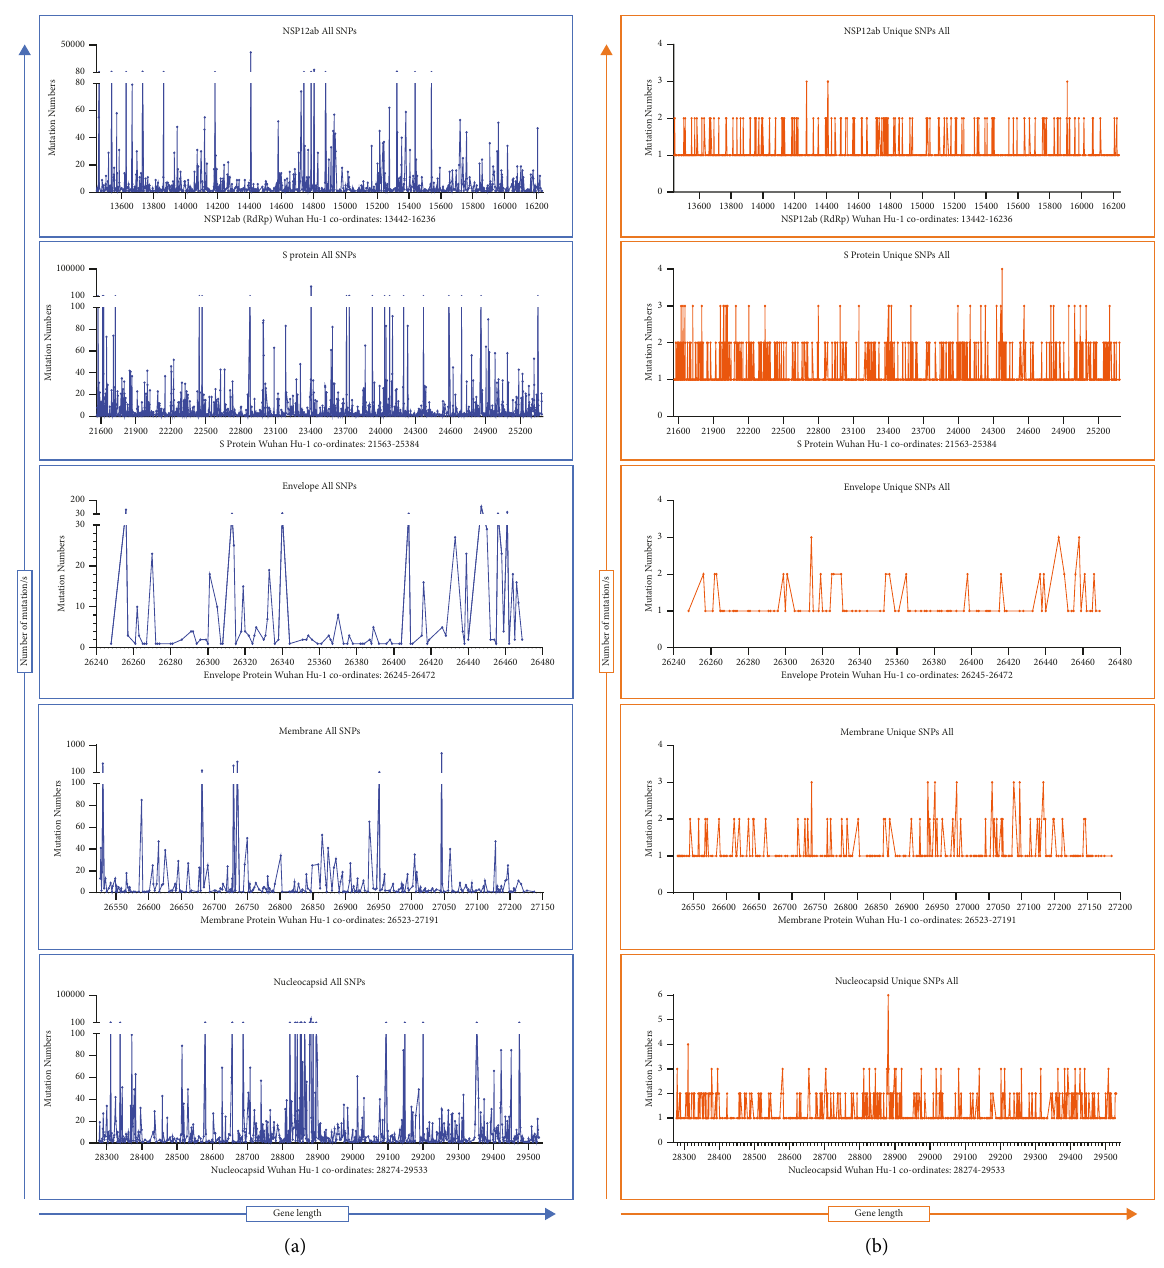
Figure 5: Visual representation of prevalent (a) and unique SNPs (b) in NSP12 (RdRp), S E, M, and N